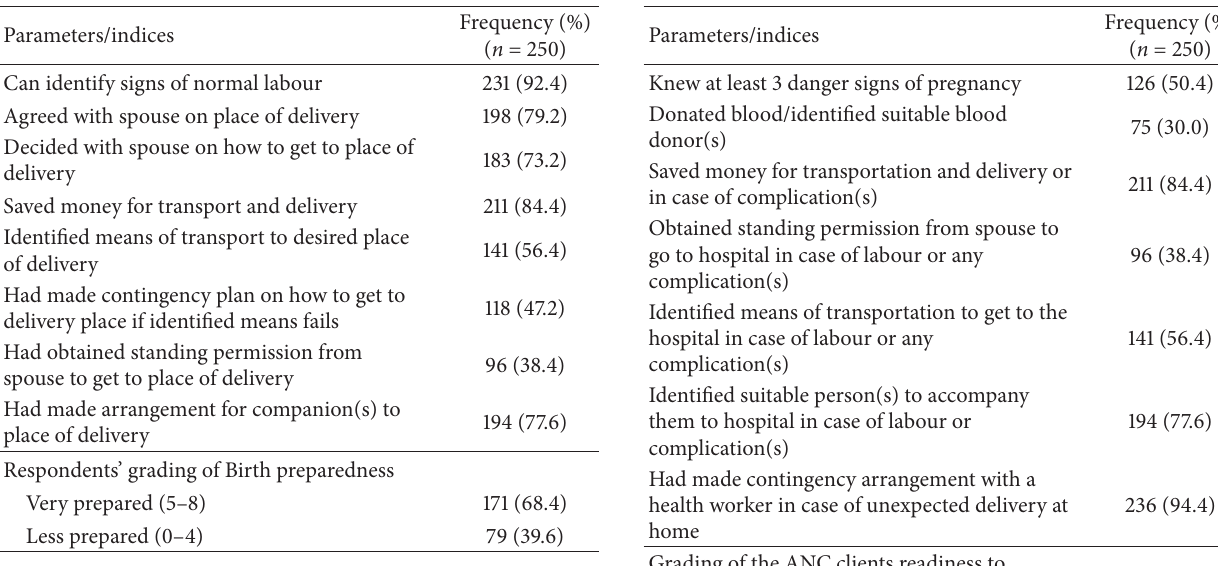
Table 3: Assesment of the ANC clients’ Birth preparedness. Table 4: Assessment of the ANC clients’ complications